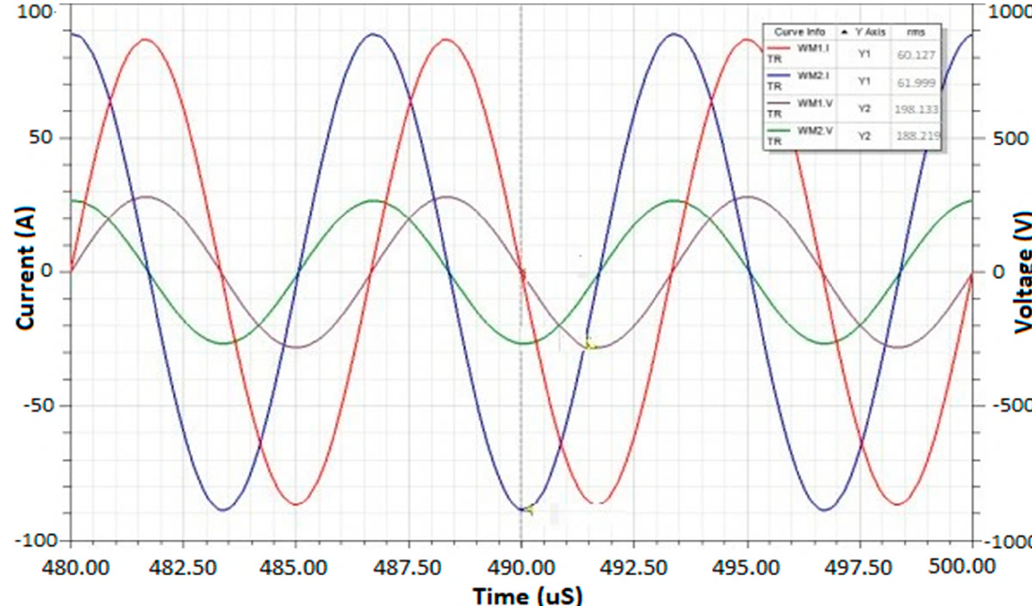
Figure 9. Input current (in blue), output current (in red), input voltage (in purple) and output voltage (in green).